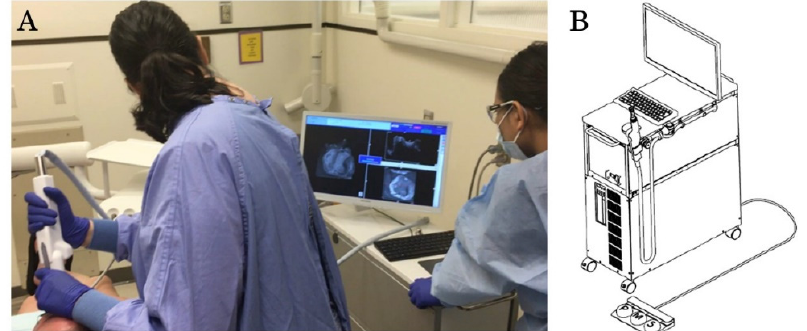
Figure 1. Clinical imaging using the prototype OCT system. The intraoral imaging probe is attached to the system. A preview image is available in real-time on the computer screen ( A ). A schematic overview of the OCT system. The recording and saving functions can be initiated using a foot pedal ( B ).